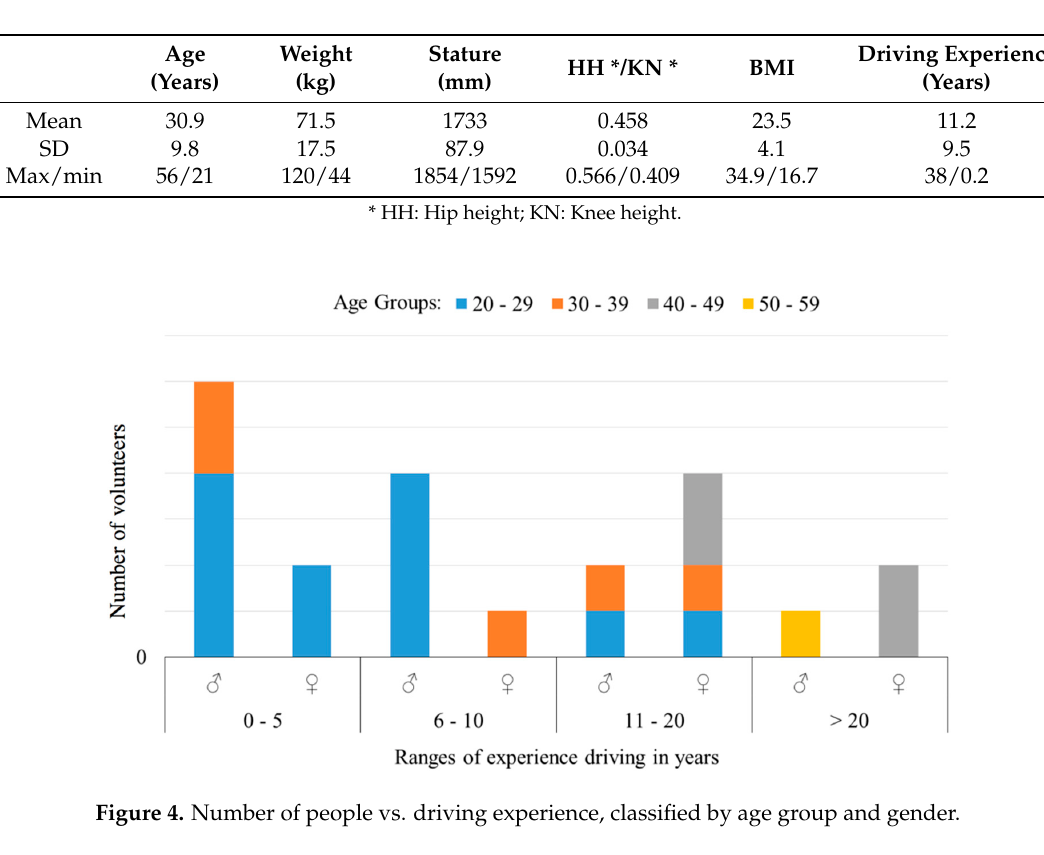
Table 6. Main characteristics of the volunteers.